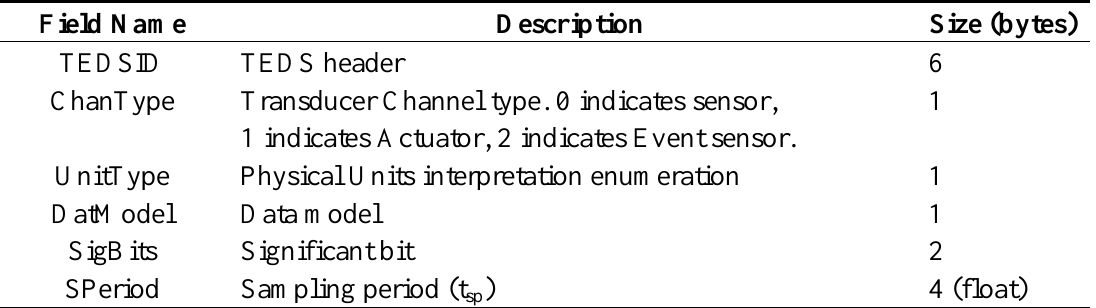
Table 3. Partial listing of Transducer Channel TEDS.